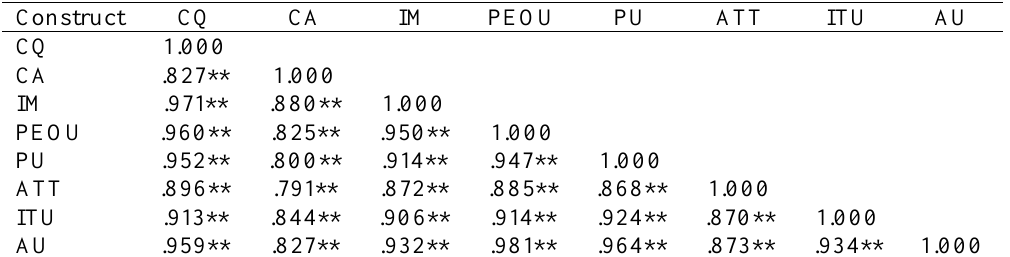
AVE Square Roots and